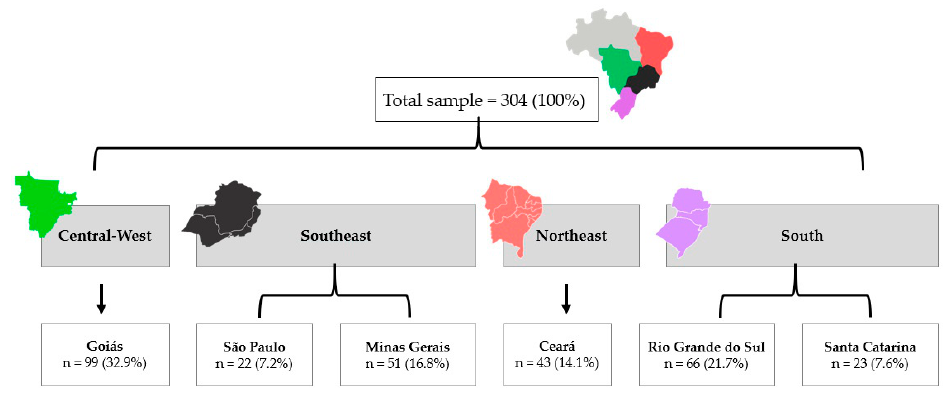
Figure 1. Women from six states of four regions of Brazil were included in this study.